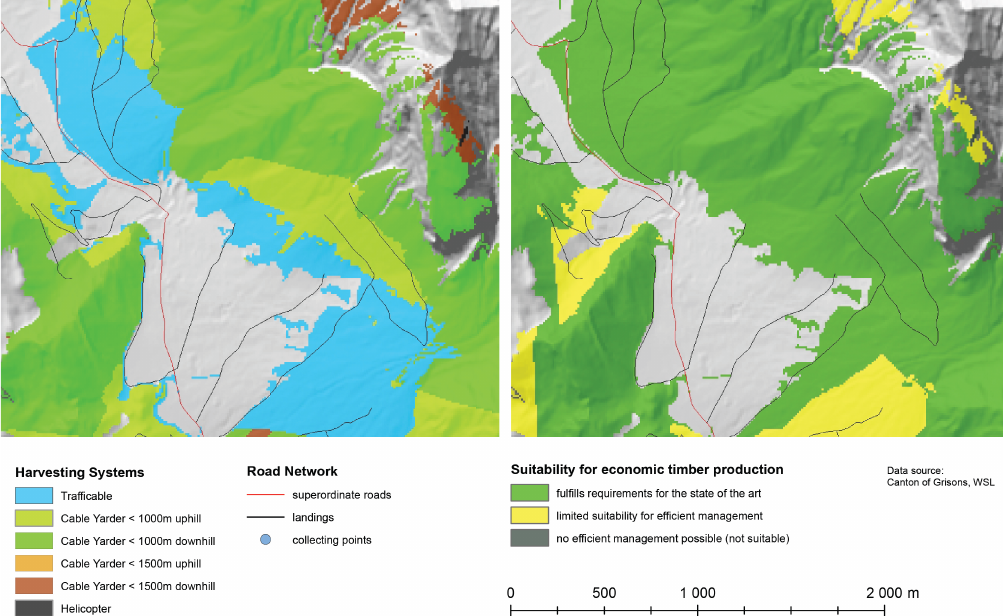
Figure 6. ( Left ) Map of harvesting systems located in the canton of Grisons, Switzerland. Especially near the transition from trafficable areas to cable yarder areas, there are some cable TPs that are isolated and surrounded by trafficable area; ( Right ) Suitability